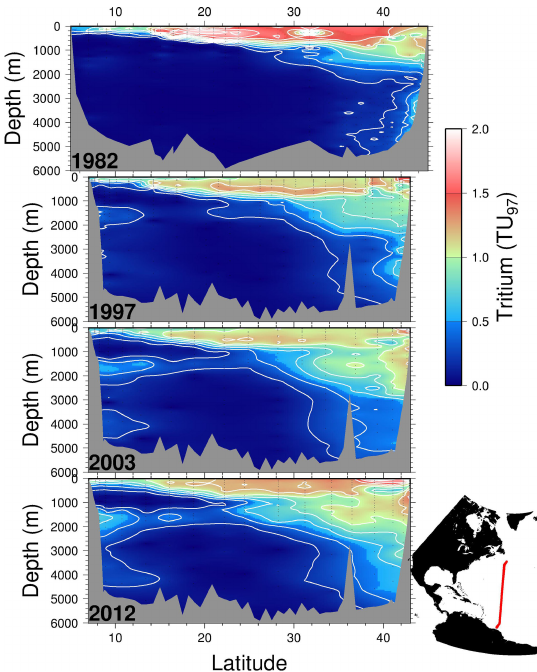
Figure 5. Four meridional tritium sections along roughly 52 ◦ W in the North Atlantic taken in 1982, 1997, 2003, and 2012. The tri- tium concentrations have been decay-corrected to a common time (1 January 1997) for comparison. Contour intervals are 0.2 TU 97 , and measurement uncertainties are of order 0.01 TU 97 or better. Due to differences in cruise tracks, the topography for the 1982 oc- cupation differs from the others.